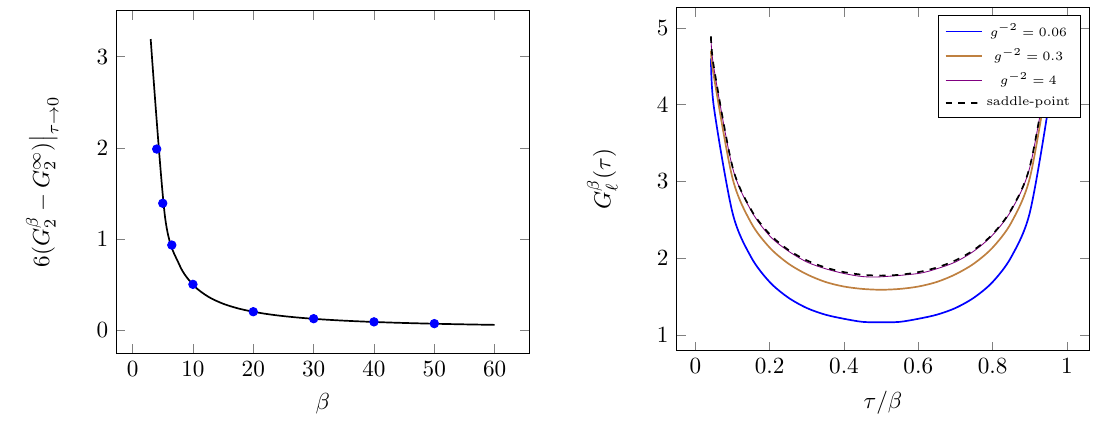
0 limit of 6( G (cid:12) ( (cid:28) ) ! (cid:0)